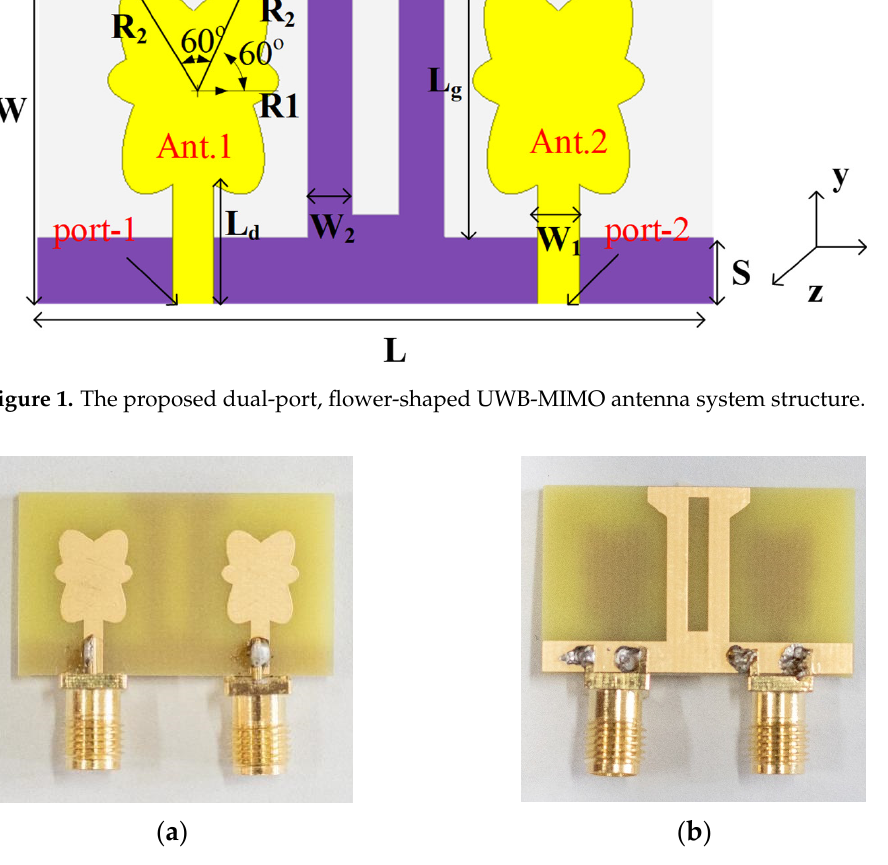
Figure 2. Fabricated prototype of the proposed dual-port, flower-shaped UWB-MIMO antenna: ( a ) front view, ( b ) back view.